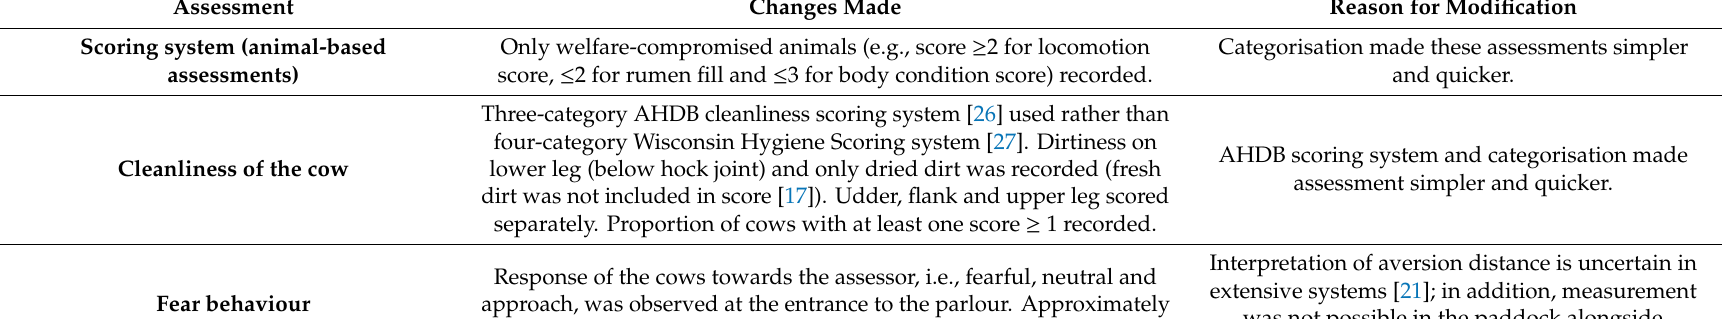
Table 2. Welfare assessment criteria that were modified before inclusion in the final protocol and rationale for their modification.